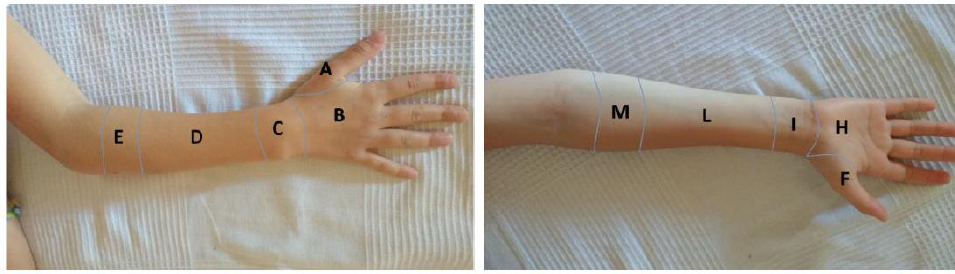
Figure 5. Definition of location/anatomic landmark to identify possible pain sites.